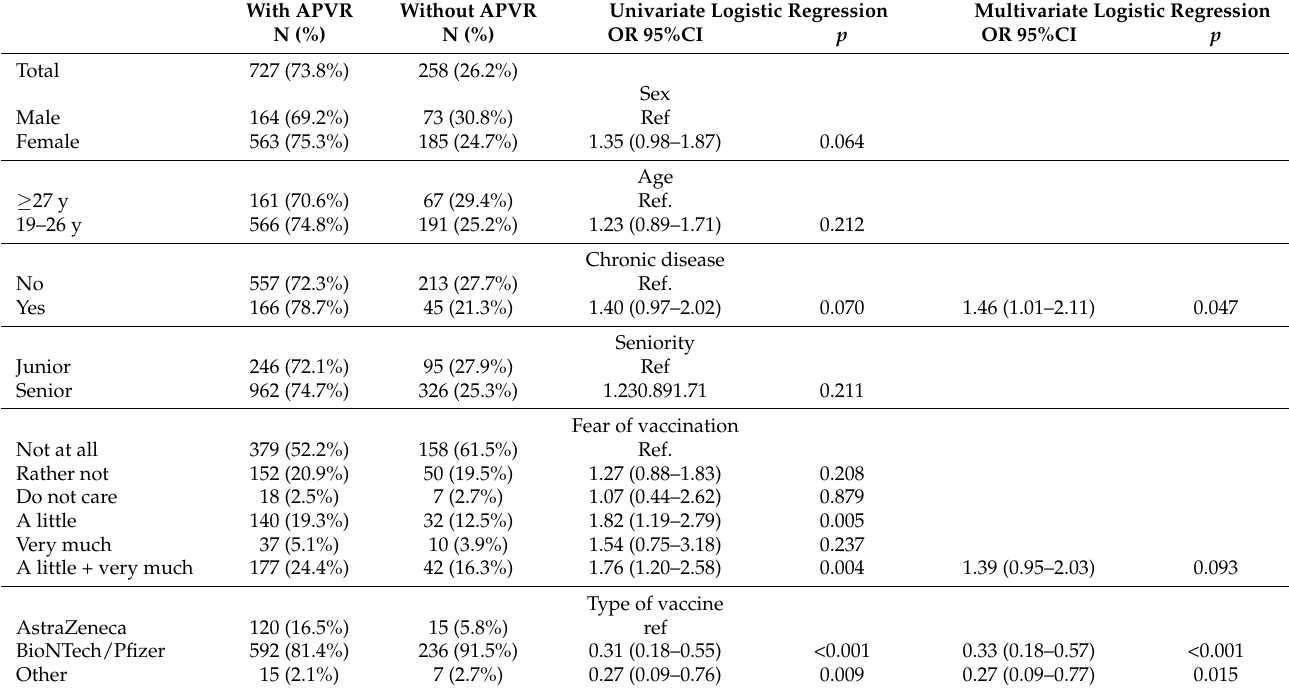
Table 6. Associations between sex, age, chronic disease, seniority, fear of vaccination, COVID infection, the type of vaccine, and the occurrence of adverse reactions after